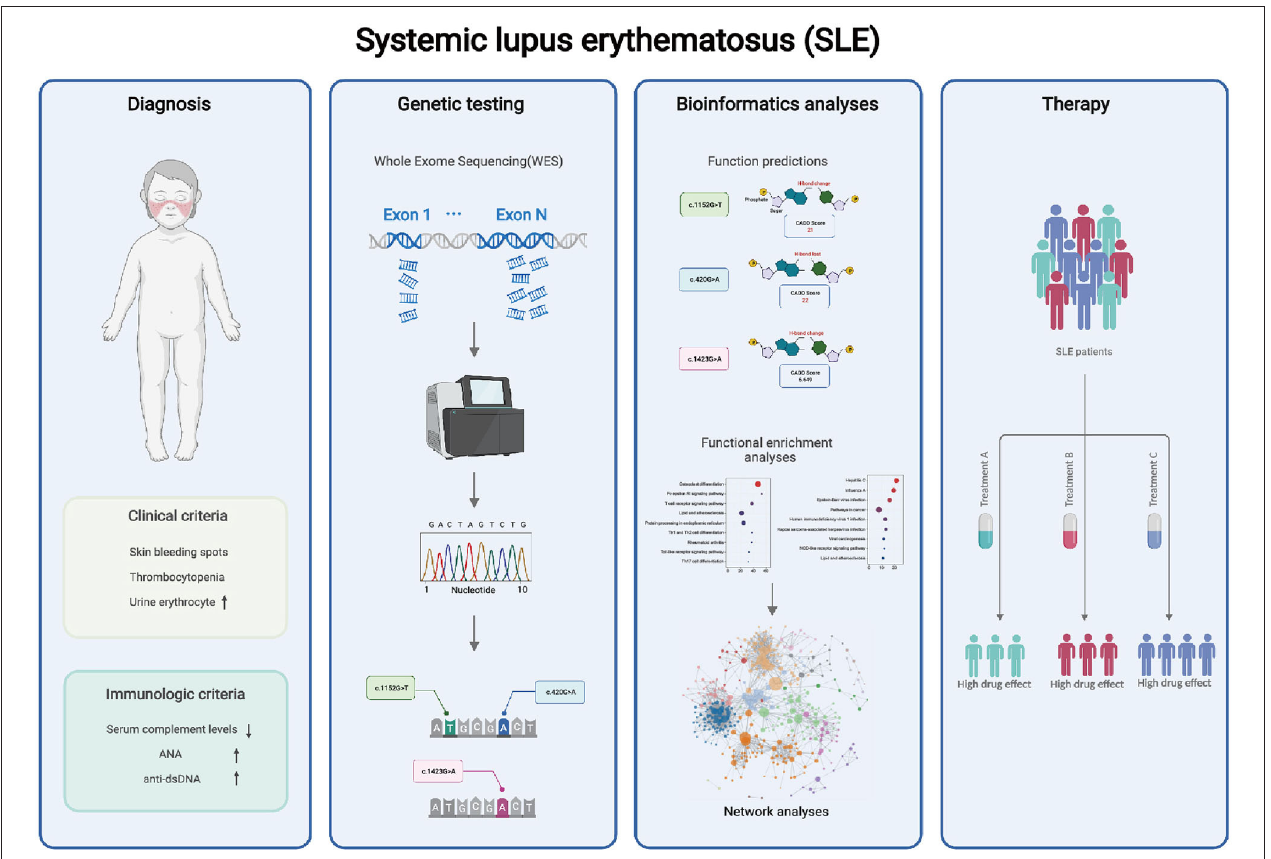
FIGURE 5 | WES may help to analyze the potential pathogenesis of patients. Our findings suggest that the combinatorial complexity of polymorphisms in ACP5 and SAMHD1 coding regions impacts SLE susceptibility, and may contribute to the abnormal immune pathway in SLE. These mutations should be considered for potential precision therapy targeting specific